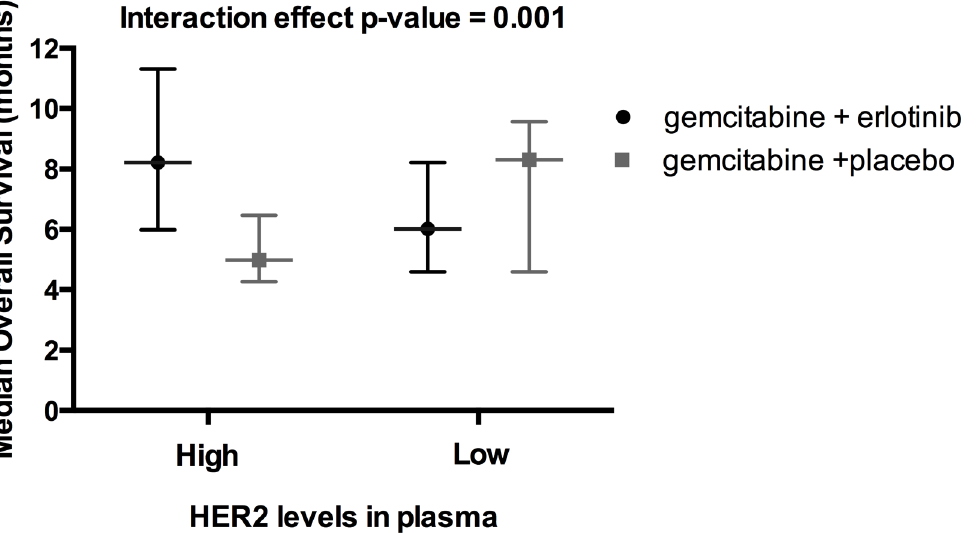
Fig 3. Erlotinib sensitivity is associated with Her2 expression. Median overall survival (with 95% CI) was improved with erlotnib treatment in patients with higher than median levels of plasma HER2 (8.2 vs. 5.0 months) but not in patients with lower plasma HER2 (6.0 vs. 8.3